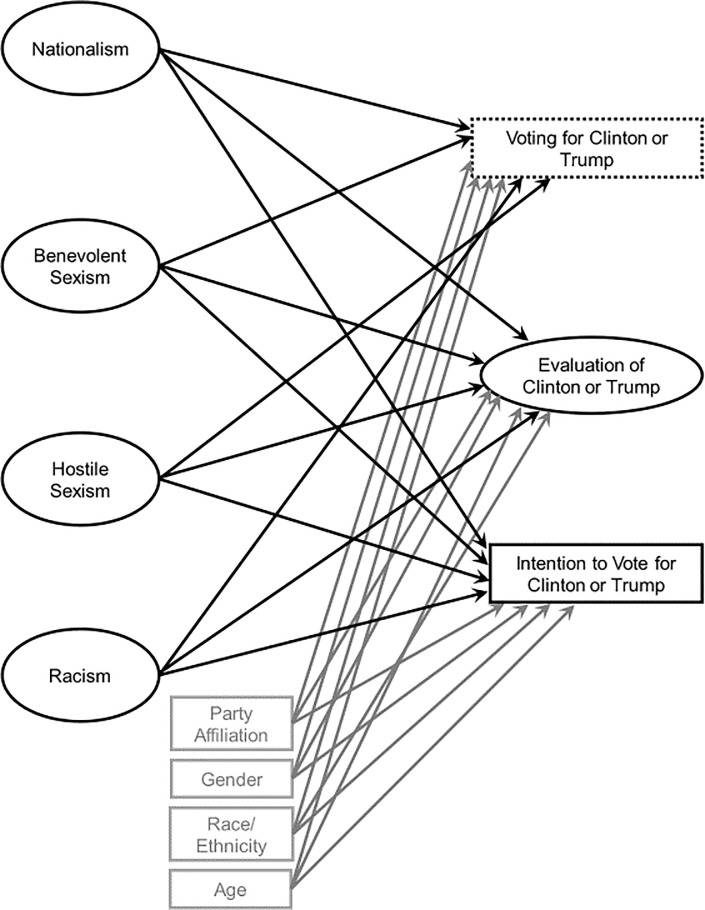
Conceptual figure depicting structural model testing the extent to which sexism toward women, modern racism, and nationalism were uniquely associated with evaluations of, intentions to vote for, and voting for Clinton or Trump.Separate models were tested for each candidate. Party affiliation, gender, race/ethnicity, and age were included as covariates.